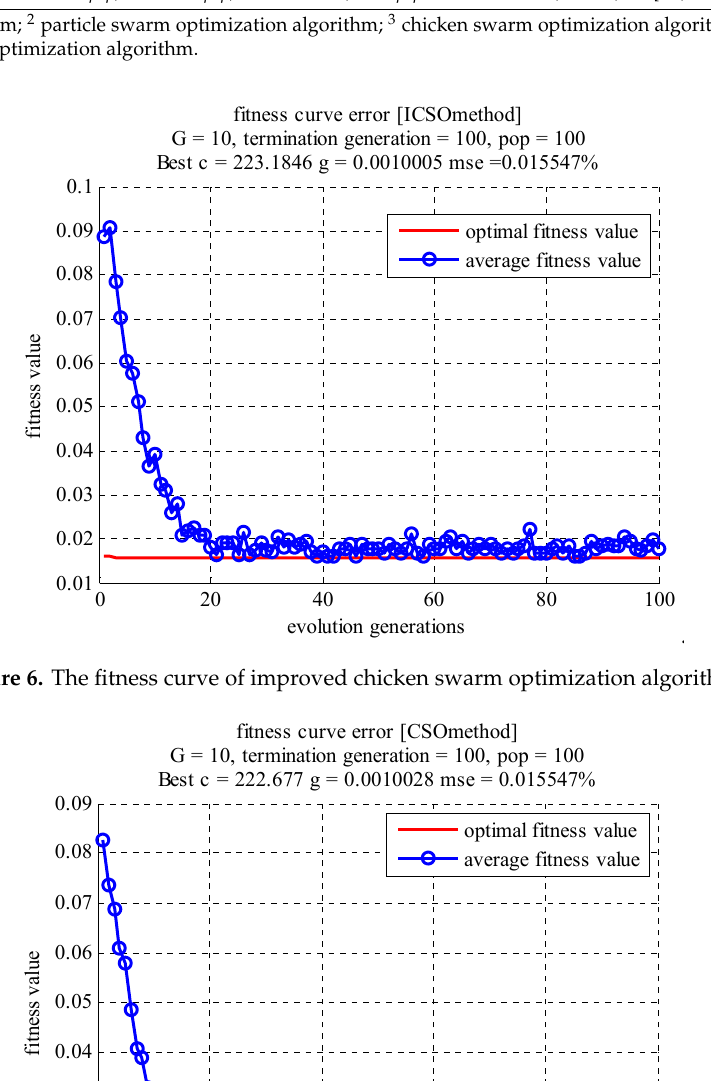
1 genetic algorithm; 2 particle swarm optimization algorithm; 3 chicken swarm optimization algorithm; 4 improved chicken swarm optimization algorithm.